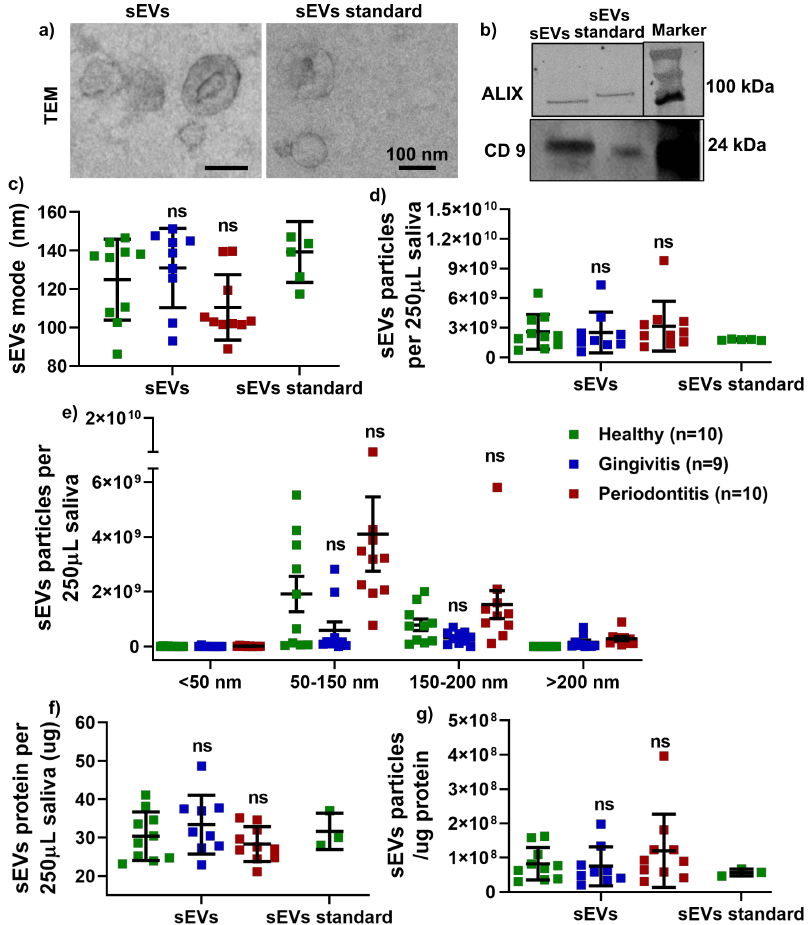
Figure 1. Characterisation of isolated salivary small extracellular vesicles (sEVs) by morphology using transmission electron microscopy (TEM) ( a ), by sEV-related proteins (ALIX and CD9) using Western blotting (WB) ( b ) and by particle mode ( c ), concentration ( d ), size distribution using Nanoparticle Tracking Analysis (NTA) ( e ), protein ( f ) and particle/ug protein ( g ). No significant difference vs healthy group (ns).